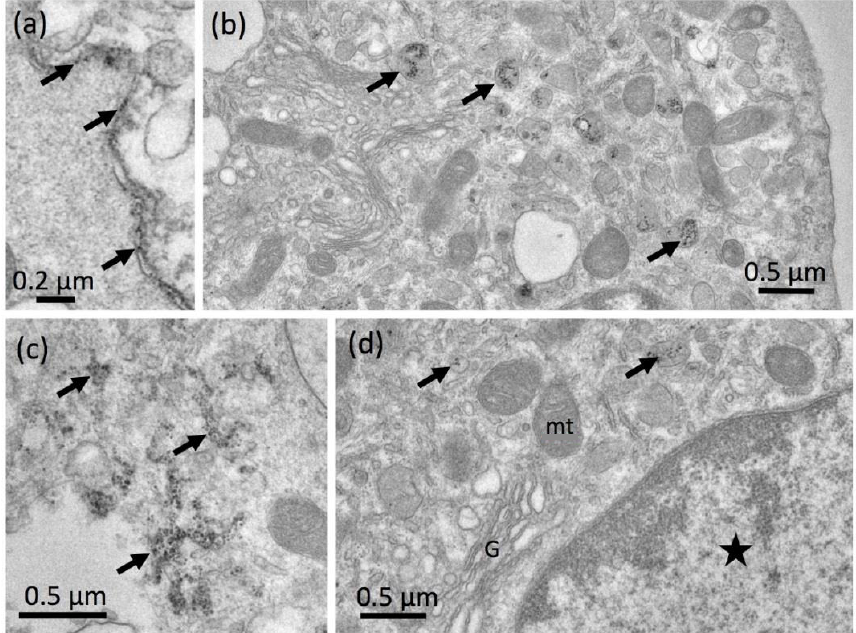
Figure 11. Detection of colloidal C-1 silica nanoparticle in NR8383 cells by transmission electron microscopy (TEM). Cells were treated with 22.5 µ g C-1 per mL in serum-free F-12K and fixed after 90 min. ( a ) C-1 particles (arrows) located in a narrow CLEFT between two macrophages, ( b ) in electron dense lysosomes (arrows), and ( c ) in tube-like endosomal compartments (arrows). ( d ) Single nanoparticles occurred in lysosomes (arrows), but not in the cytoplasm or in organelles such as mitochondria (mt), Golgi apparatus (G), or in the nucleus